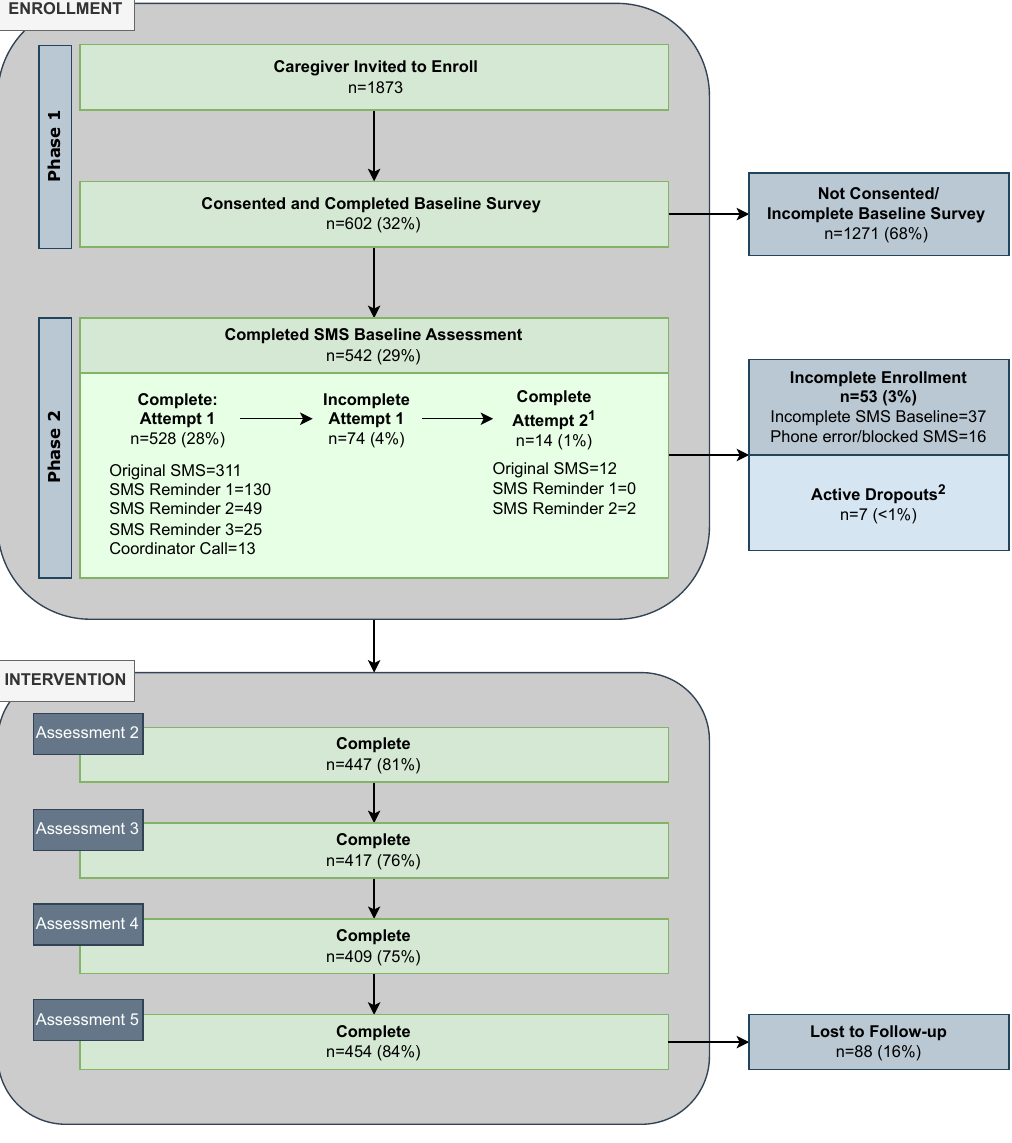
Figure 1. Kids SIPsmartER caregiver SMS consort diagram. 1 Non-responders at SMS Baseline Assessment, Attempt 1 ( n = 74) are not considered fully enrolled. They receive a second attempt to complete this assessment and enroll in the intervention at the same time enrolled caregivers receive Assessment 2. For the 14 caregivers that responded at Attempt 2, SSB intake data was carried forward for Assessment 2. 2 Active dropout reflects a caregiver request to stop SMS messages (although caregivers could request to stop receiving SMS at any time during the intervention, none did so past Cycle 2, active dropouts were removed from analysis and represented as a dropout at